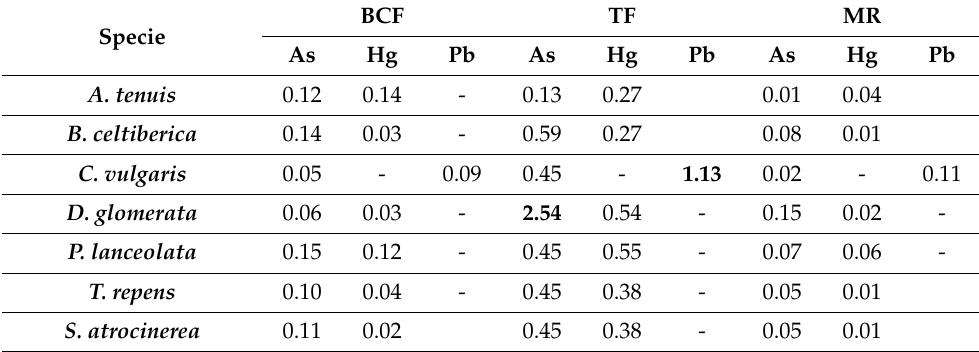
Table 5. Accumulation factors for the plant species studied (BCF: Bioaccumulation Factor. TF: Translocation Factor. MR: Mobility